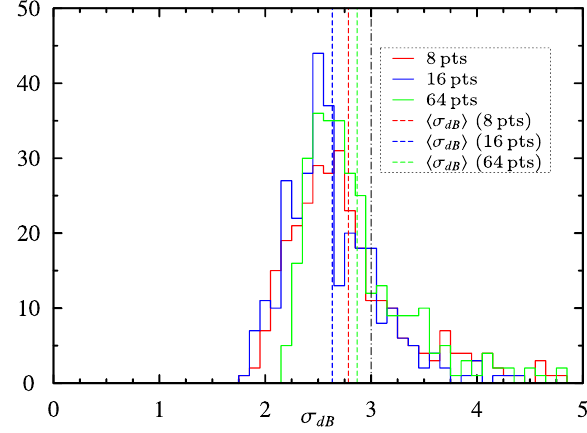
Figure 6: Histograms of values of σ dB obtained for 8 (red), 16 (blue), 64 (green) measurement points in the conven- tional RC. The red, blue and green dashes represent respec- tively the average value of σ dB for 8, 16 and 64 points. The limit at 3 dB is also shown. The percentages of values above this limit are respectively: 25.7 % ,16 % et 27.3 % .